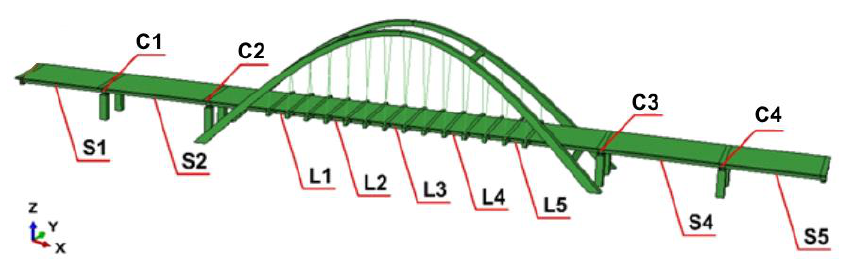
Figure 15. Representative points chosen for the dynamic analyses.